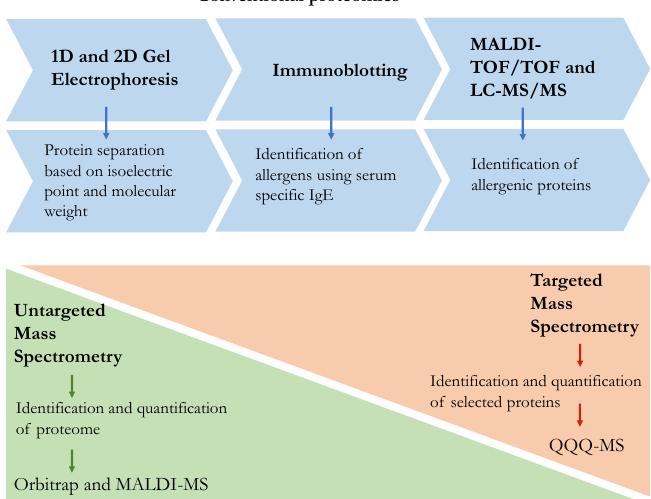
Figure 1. Key elements of proteomic approaches employed in allergenicity assessment. The blue color indicates conventional proteomics, and orange and green highlight targeted and untargeted mass spectrometry, respectively. Figure acronyms: 1D and 2D gel electrophoresis = one and two dimensional gel electrophoresis; TOF = time of flight; MALDI-TOF / TOF = Matrix-assisted laser desorption ionisation-tandem mass spectrometry (TOF); LC-MS / MS = liquid chromatography-tandem mass spectrometry; QQQ-MS = triple quadrupole mass spectrometer.